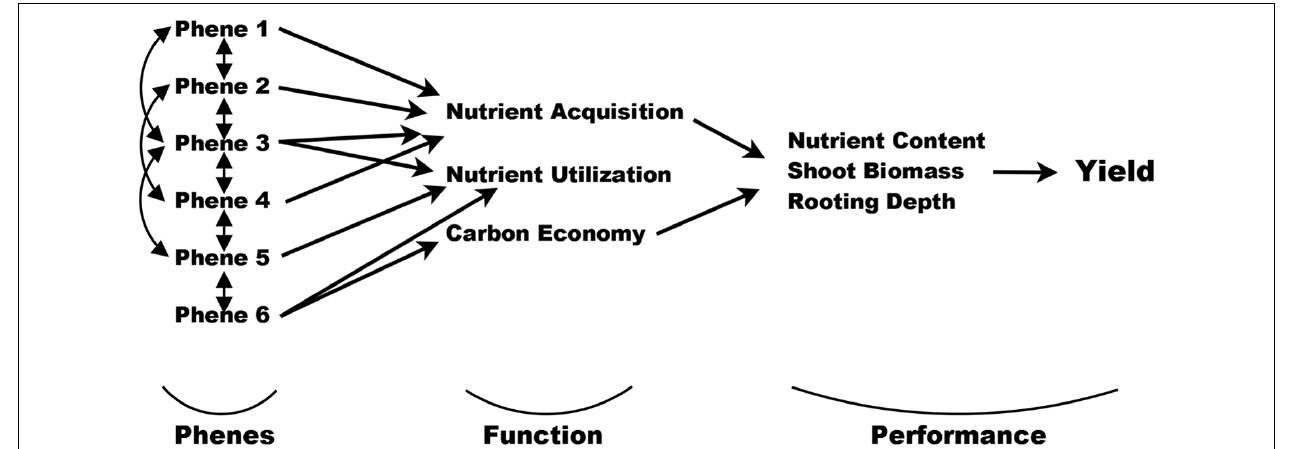
FIGURE 2 | Phenes and their interactions influence plant functions such as nutrient acquisition, utilization, and carbon economy. In turn, these functions affect agricultural performance measures such as shoot biomass and nutrient content. Ultimately, all these lead to yield (or fitness).Yield is far